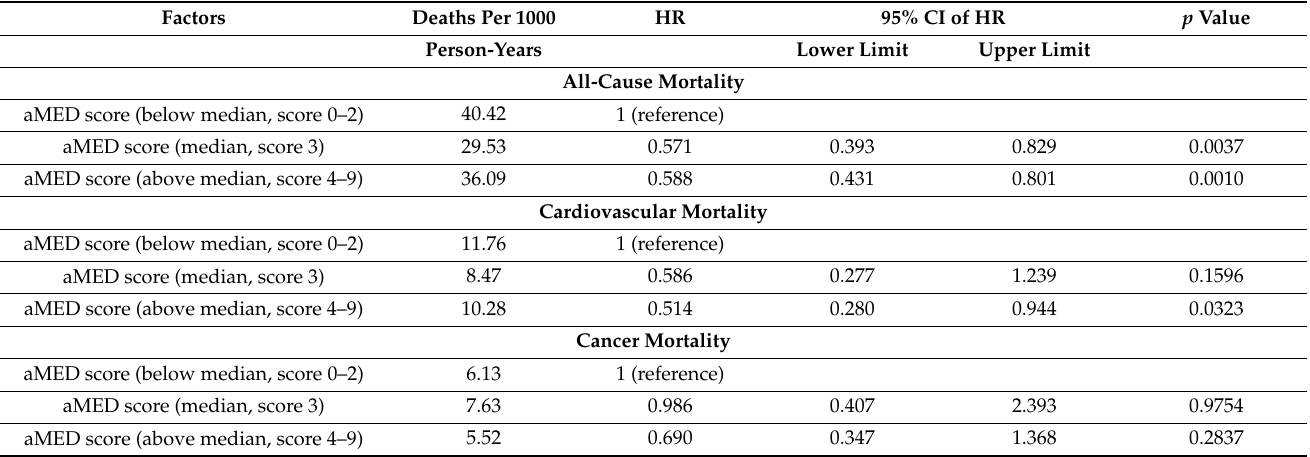
Table 4. Secondary analysis using Cox regression in NHANES participants with a history of coronary heart disease or stroke for all-cause, cardiovascular, and cancer mortality that excluded those who died within the first two years of the NHANES study